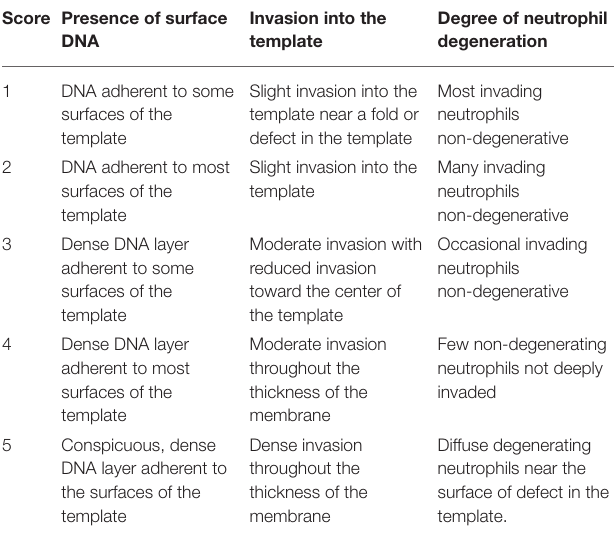
TABLE 2 | Electrospun templates were evaluated by a veterinary pathologist in a blinded fashion at 1 day after implantation in a subcutaneous rat implant model. Score Presence of surface DNA